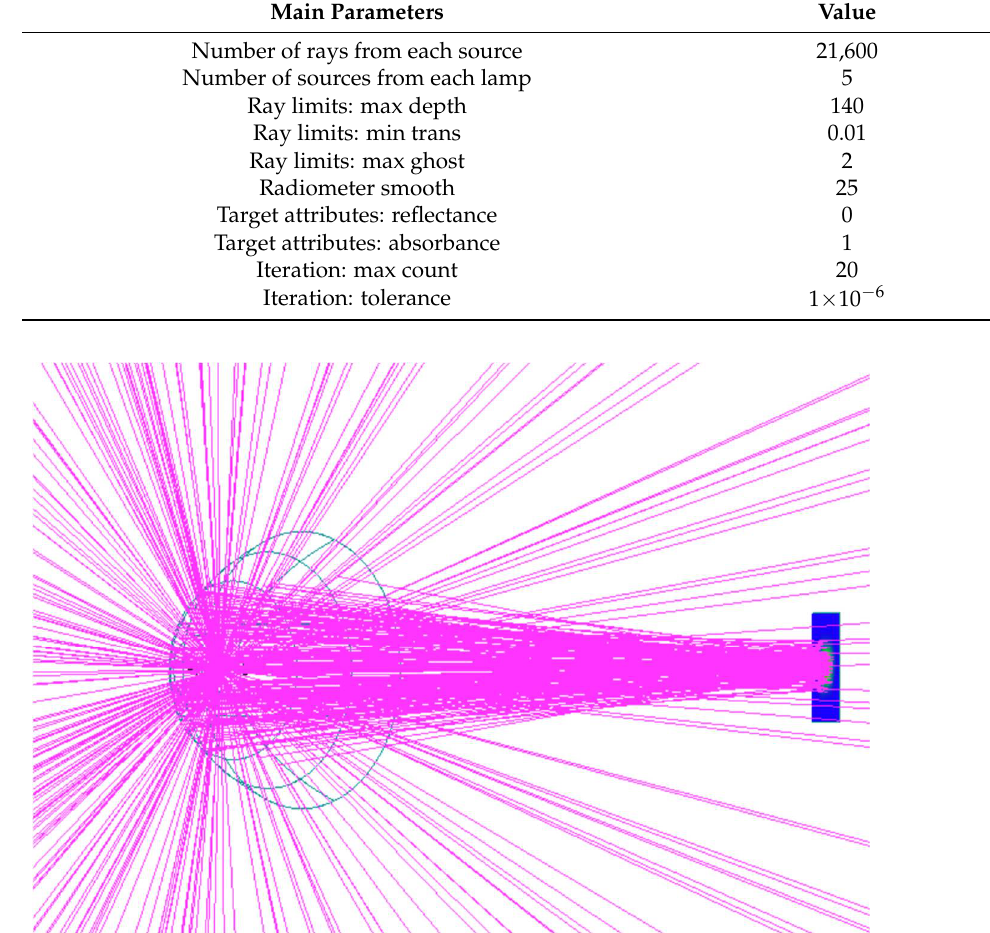
Figure 7. Example of Opticad simulation of a lamp. Table 2. Main parameters of Opticad simulations.